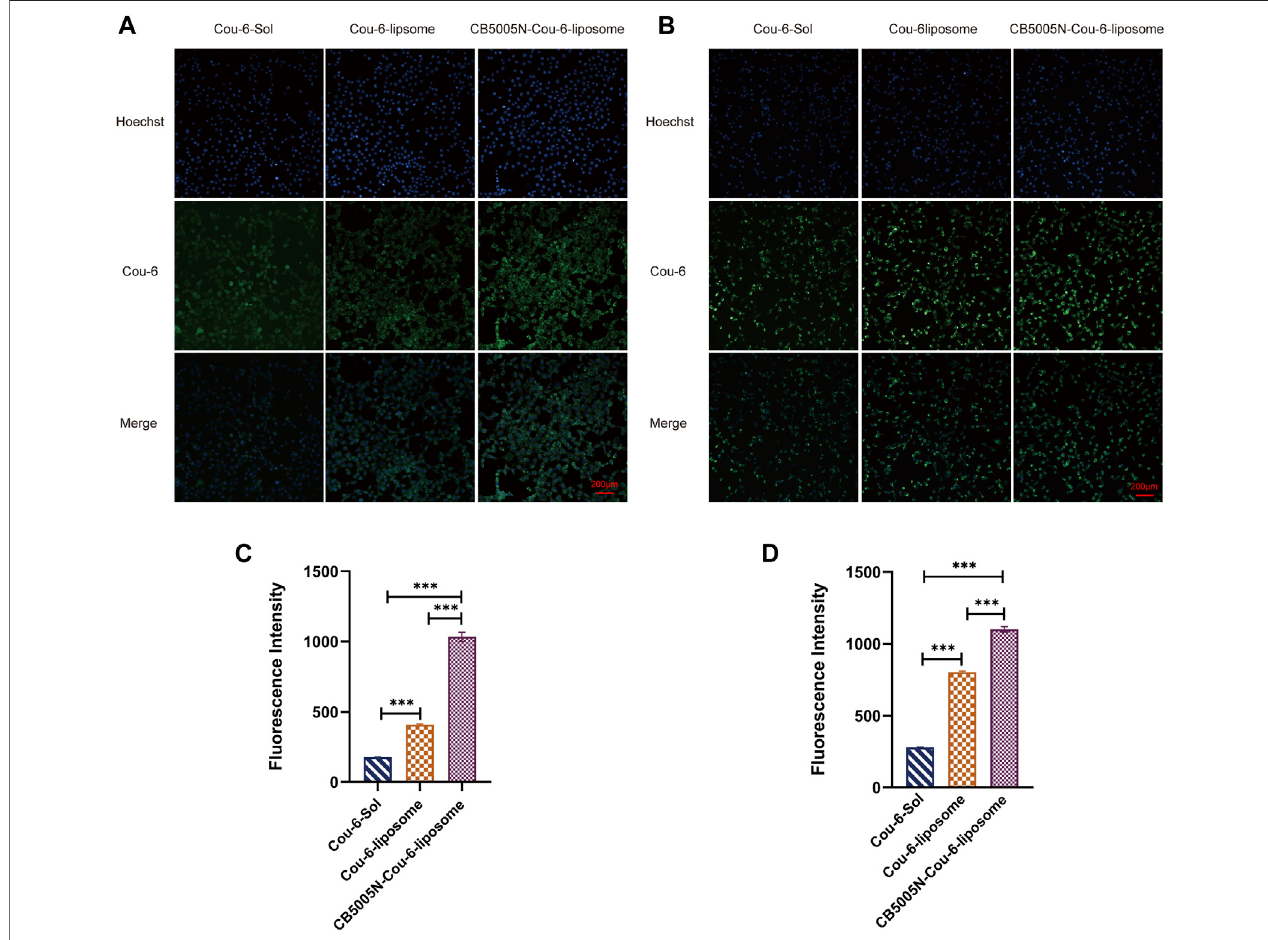
FIGURE2|(A) Thepicturesofcelluptakeby4T1cellafter4 hincubation. (B) TheimagesofcelluptakebyMDA-MB-231cellafter4 hincubation. (C) Fluorescence valuesofCou-6in4T1cellsineachgroup. (D) FluorescencevaluesofCou-6inMDA-MB-231cellsineachgroup.(Resultsareexpressedasmean±SD, n =6.Scalebar = 200 μ m) *** p <